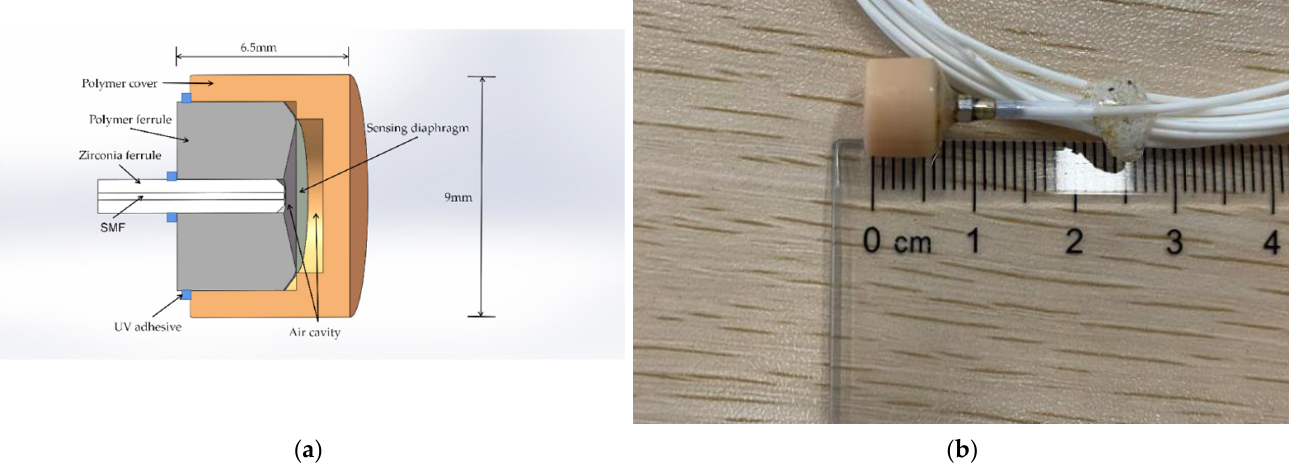
Figure 1. ( a ) Schematic structure of the polymer cavity sensor; ( b ) photograph of the polymer cavity sensor.